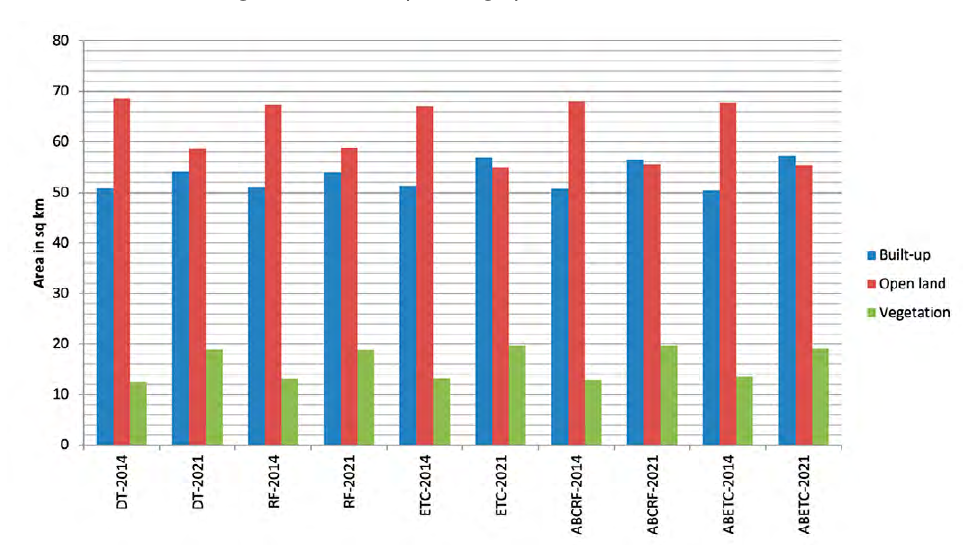
Figure 10. Area comparison graph of Rajkot data